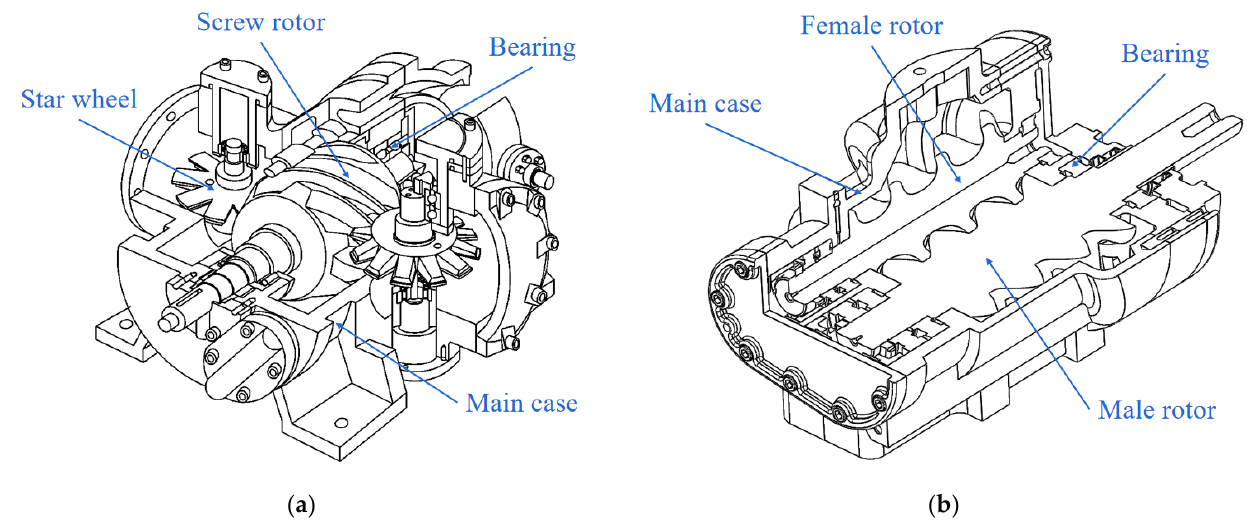
Figure 1. Basic structure of typical screw machines. ( a ) Single-screw machine. ( b ) Twin-screw machine.